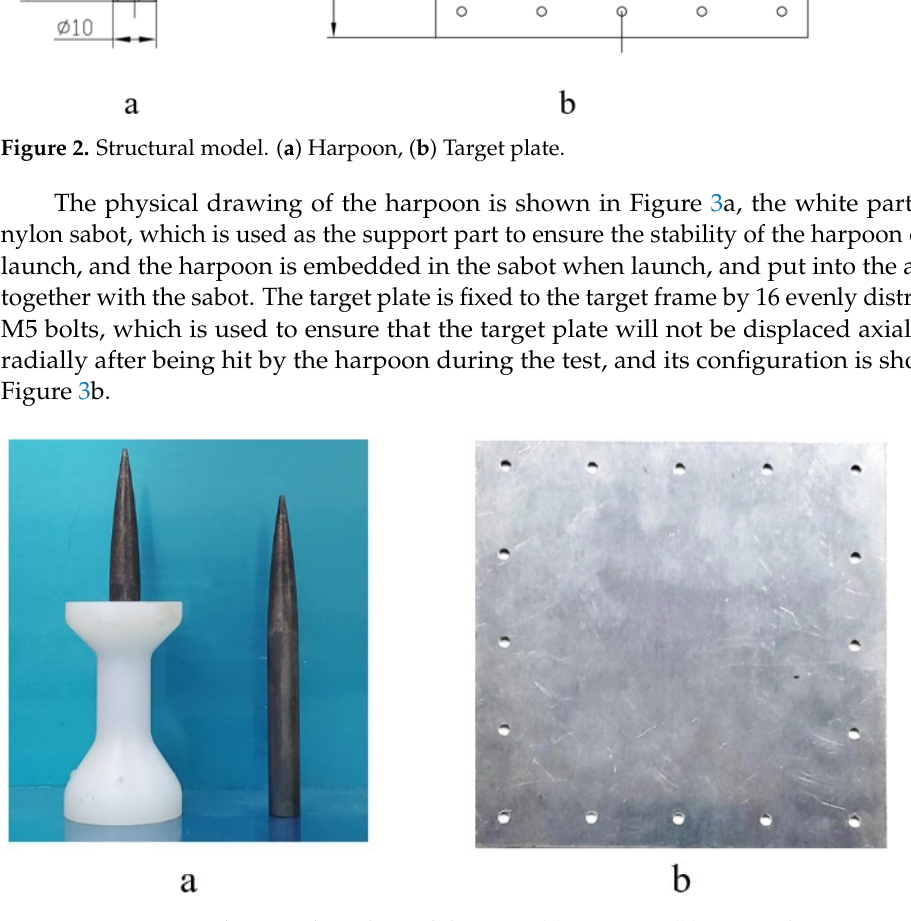
Figure 3. Harpoon and target plate physical drawing. ( a ) Harpoon, ( b ) Target plate.